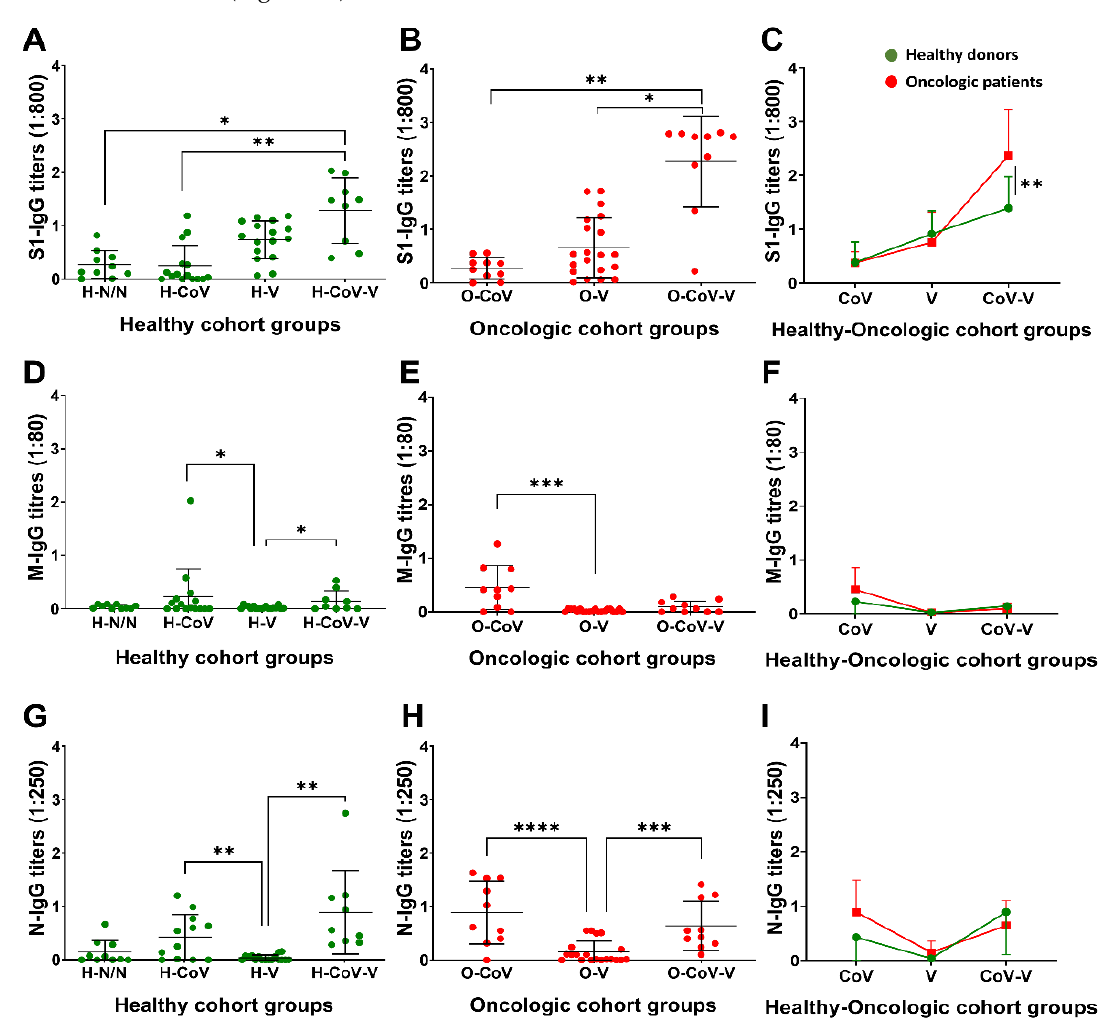
Figure 1. IgG antibody titres against S, M and N proteins. Backgrounds from paired technical controls were removed from each sample. ( A – C ) S-specific IgG antibody titres in sera (1:800) from healthy donors and oncologic patients. ( D – F ) M-specific IgG antibody titres in sera (1:80) from healthy donors and oncologic patients. ( G – I ) N-specific IgG antibody titres in sera (1:250) from healthy donors and oncologic patients. ( A , B , D , E , G , H ) Non-parametric Kruskal–Wallis test was used for multiple comparisons followed by Dunn’s test for selected pair-wise comparisons. ( C , F , I ) Pair- wise comparisons were performed using the Mann–Whitney U-test. H-N/N, non-vaccinated, non- COVID-19 donors; H-CoV, healthy donors with previous COVID-19 infection; H-V, vaccinated healthy donor; H-CoV-V, vaccinated healthy donor with previous COVID-19; O-CoV, oncologic patient with previous COVID-19; O-V, vaccinated oncologic patients; O-CoV-V, vaccinated oncologic patients with previous COVID-19; *, **, *** and **** indicate significant ( p < 0.05), very significant ( p < 0.01), highly significant ( p < 0.001) and very highly significant ( p < 0.0001) differences,